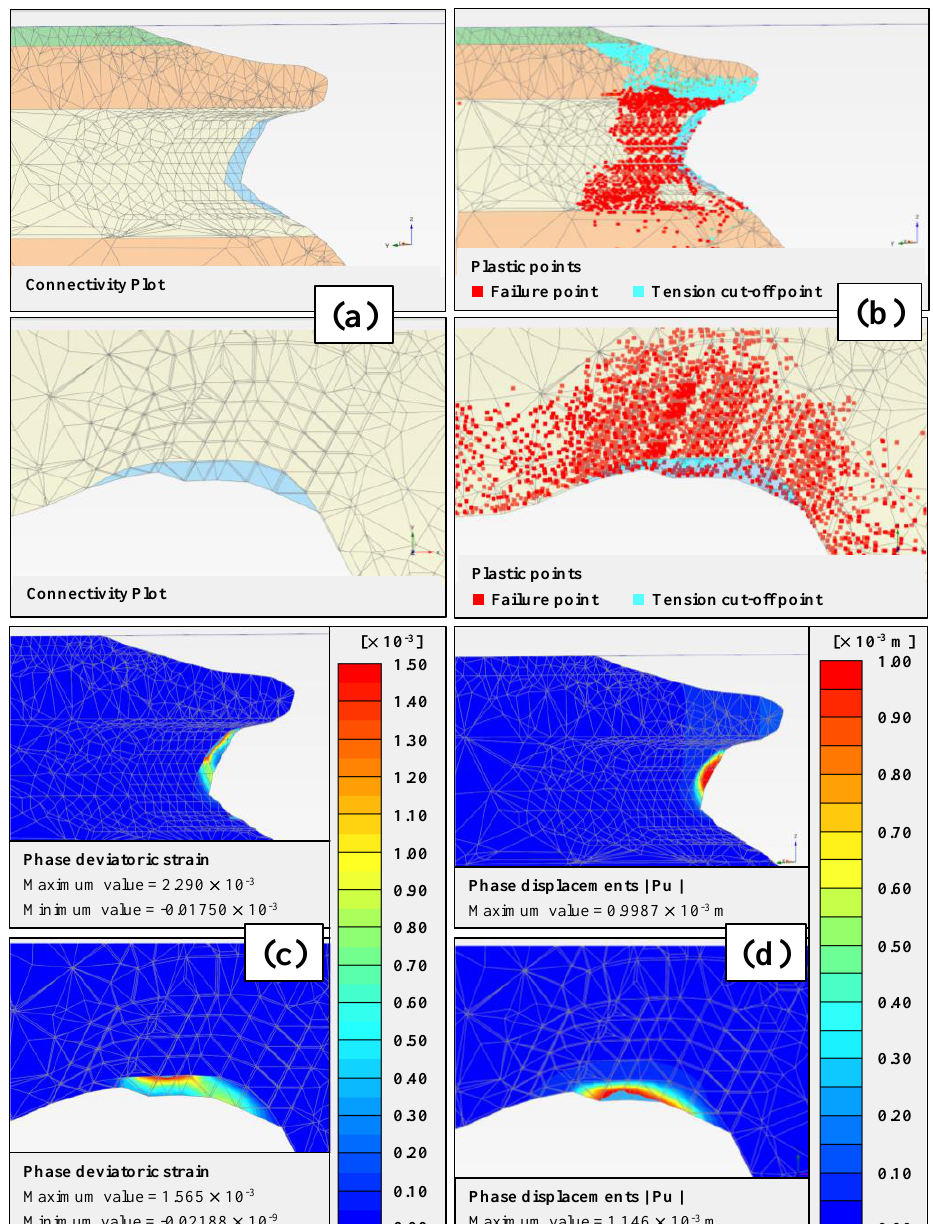
Figure 13. Results of the simulation of the rock block detachment (on the vertical and horizontal section): ( a ) Plot with detached block in light blue; ( b ) plastic points distribution; ( c ) deviatoric strains; ( d ) displacements.